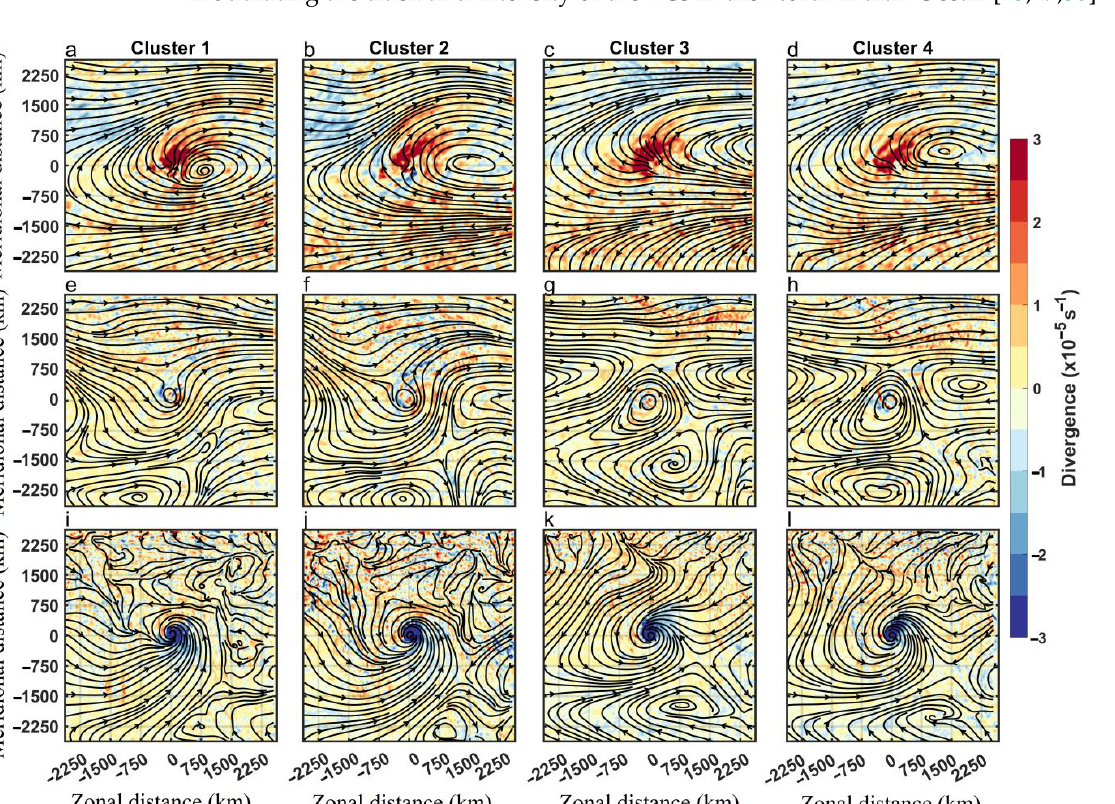
served in all clusters at all selected levels. In the lower level of the atmosphere (950 hPa), higher RH (~90%) is observed equatorward to the vortex centre, and relatively lesser RH (~60%) is distributed on the poleward side in all of the clusters. In the upper atmosphere (200 hPa), variation in RH is similar to the lower atmosphere (950 hPa) with relatively lesser magnitudes with RH ~70% in the equatorward and ~20% in the poleward from the vortex centre. The low moist air (dry air) observed in the upper level is present in the West-northwest (WNW) direction from the vortex centre, clearly evident in Cluster-1 and Cluster-2, whereas in the mid-troposphere (500 hPa), the composites of RH reveal the presence of a dipole pattern with higher moist air near the vortex centre and lower moist air (dry air) observed in the WNW direction. The presence of dry air in the northwest quadrant of the TC centre can decrease upward buoyancy and subsequently influence the intensity of the TCs. In addition, the location of RH (moist/dry) at the mid-tropospheric level can also modulate TC intensity by promoting or inhibiting rain bands and convec- tion into the outer core region [4,59,60].